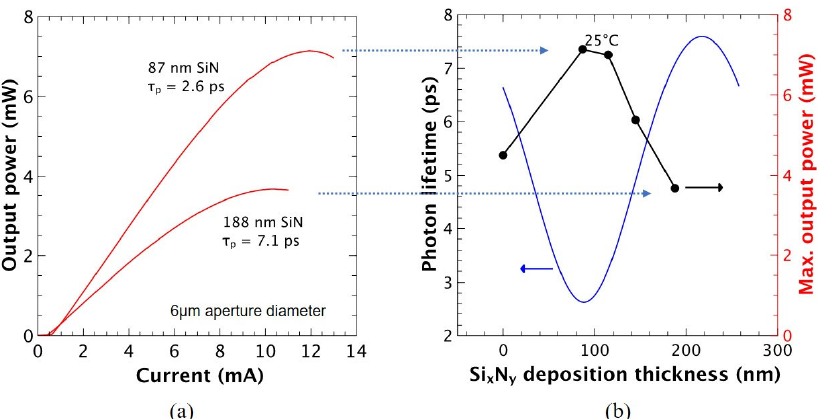
Figure 5. ( a ) Output power as a function of current of a 6 µ m oxide-aperture diameter VCSELs with different thicknesses of SiN and photon lifetimes. ( b ) Photon lifetime and max. output power of the VCSEL as a function of the thickness of SiN [16].